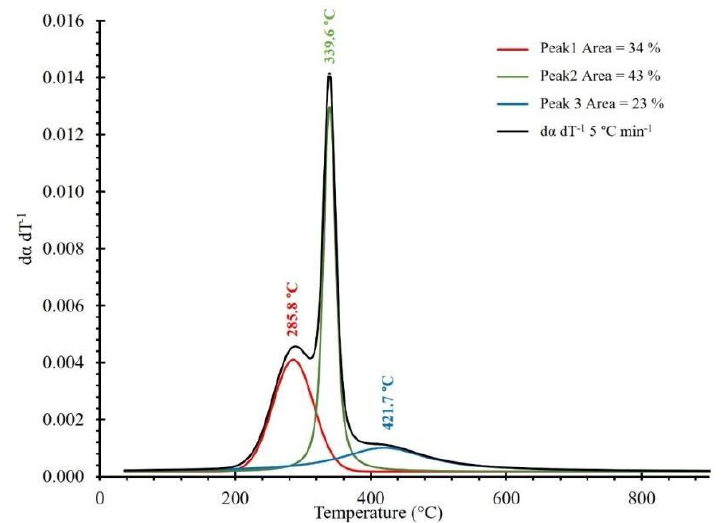
Figure 3. Deconvolution curves for the pyrolysis of BCS at 5 °C/min and particle size Dp 4 .